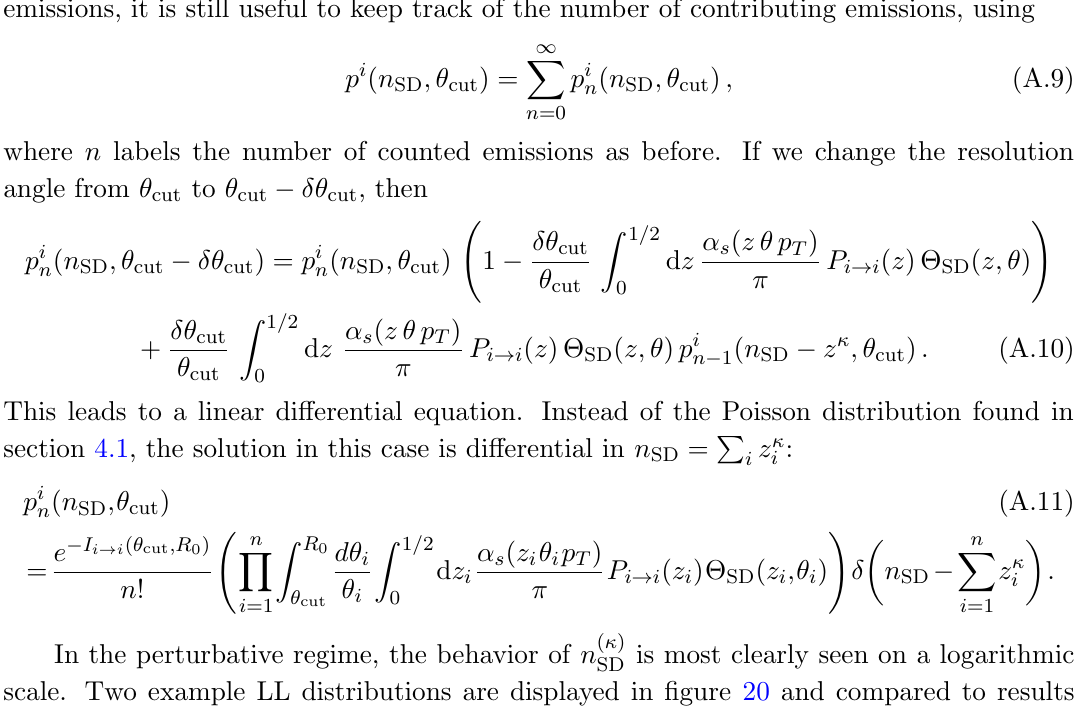
Figure 21. RG evolution of collinear-unsafe weighted soft drop multiplicity with z (cid:20) = 1, for the (a) quark-singlet and (b) gluon